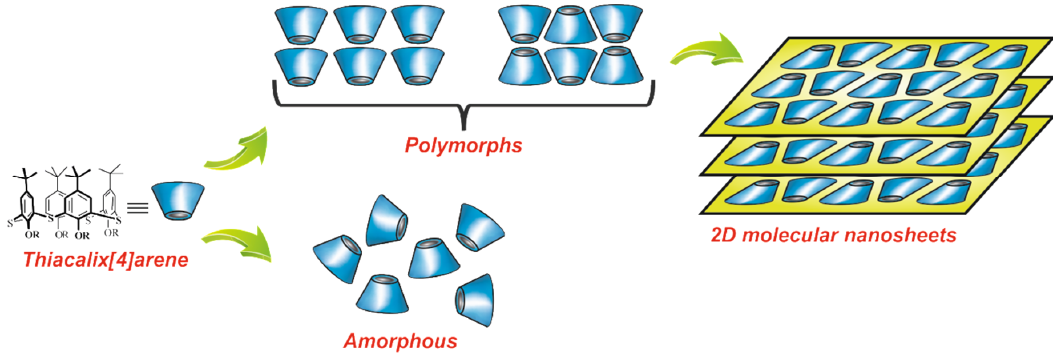
Figure 1. Supposed scheme for the formation of 2D monomolecular nanosheets based on p - tert - butylthiacalix[4]arene derivatives in the solid